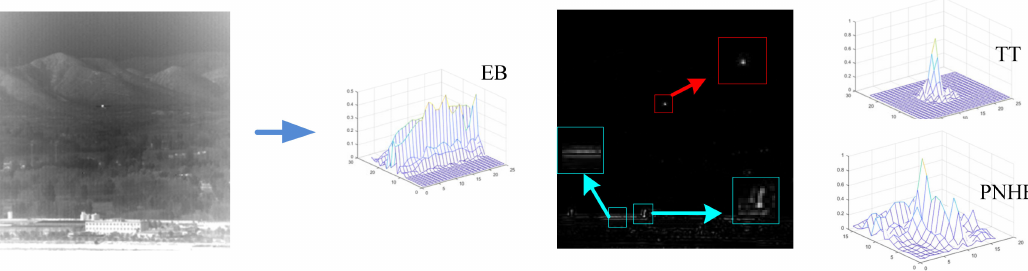
Figure 3. Result of the Gaussian high-pass